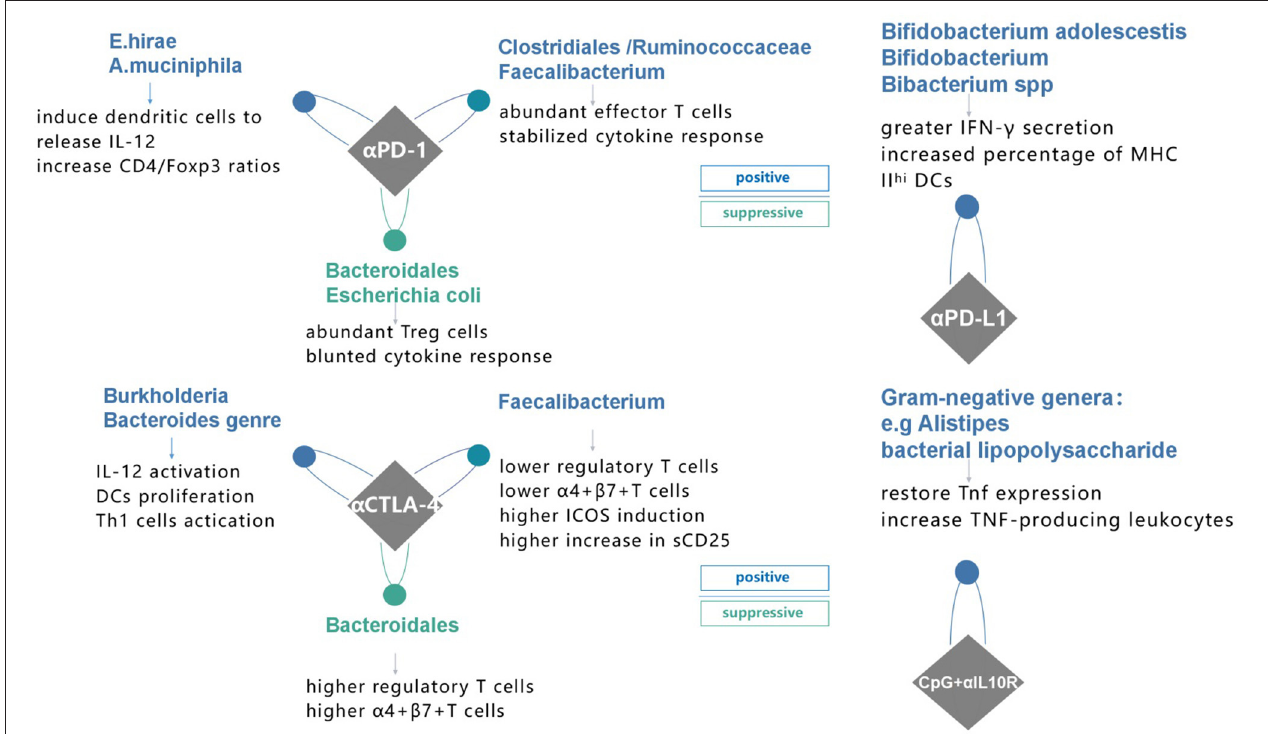
FIGURE 1 | Specific species of bacteria have proven to affect immune response to four different immunotherapies and possible mechanisms in recent studies. PD-1 programmed death receptor-1, PD-L1 programmed death-ligand 1, CTLA-4 cytotoxic T lymphocyte-associated protein 4, α PD-1, anti-PD-1 therapy; α PD-L1, anti-PD-L1 therapy; α CTLA-4, anti-CTLA-4 therapy; CpG + α IL10R, TLR9 ligand CpG plus anti-IL10R antibody.